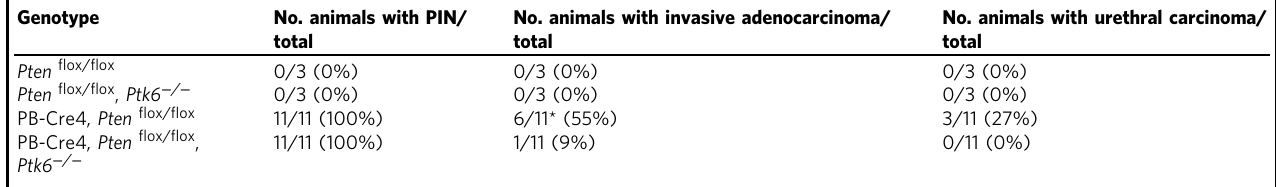
Table 1 Effects of Ptk6 disruption in the PB-Cre4, Pten fl ox/ fl ox mouse model of prostate cancer Genotype No. animals with PIN/ No. animals with invasive adenocarcinoma/ total total